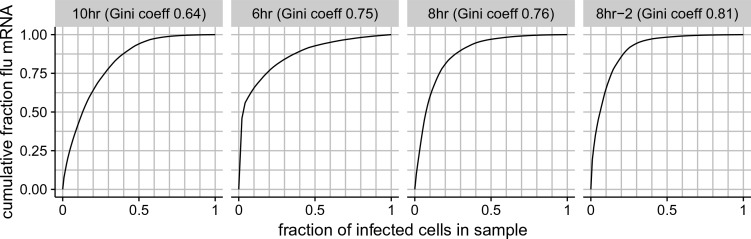
Cumulative distributions of viral mRNA per cell and Gini coefficients.The total fraction of all viral mRNA among infected cells that is attributable to a given fraction of these cells. For instance, the plot for the 8 hr sample shows that ∼50% of all viral mRNA is derived from ∼8% of the infected cells. The facet titles above each plot also give the Gini coefficient (Gini, 1921) that calculates the heterogeneity in the distribution of viral mRNA among infected cells. Gini coefficients of 0 indicate a perfectly even distribution across cells, and Gini coefficients of 1 indicate a maximally skewed distribution.